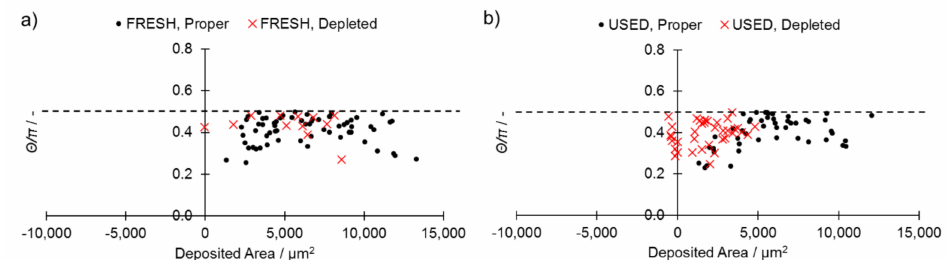
Figure 6. Comparison of proper and depleted STCSs’ shape parameters for ( a ) FRESH and ( b ) USED powders in function of area of STCS. The dashed line represents the stability condition presented in Equation